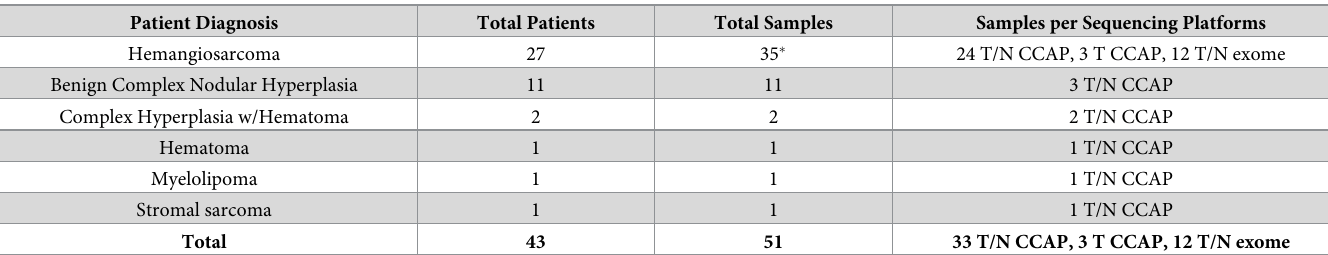
Table 1. Samples and sequencing